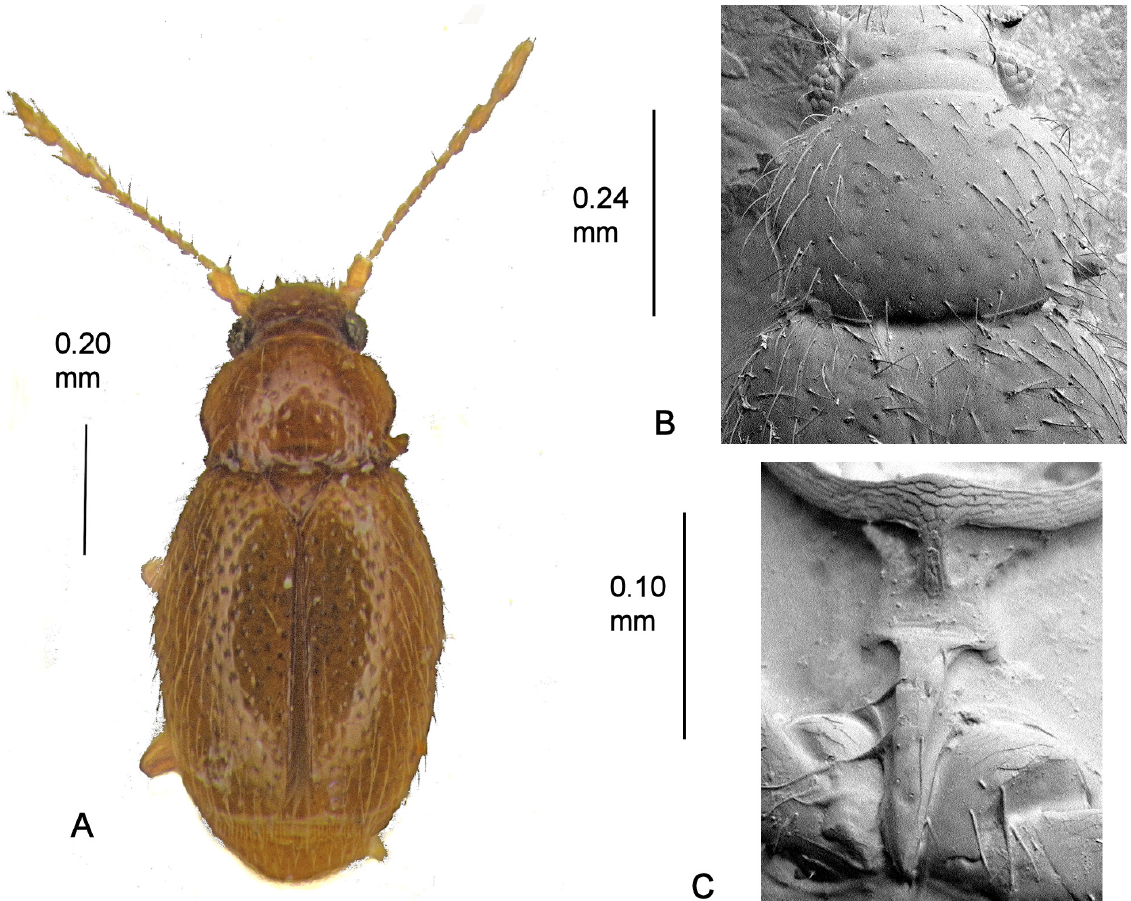
Fig. 63 . Cissidium angusi sp. nov. A . Habitus. B . Pronotum, × 520. C . Mesoventrite showing median process of collar, mid-keel and keel,